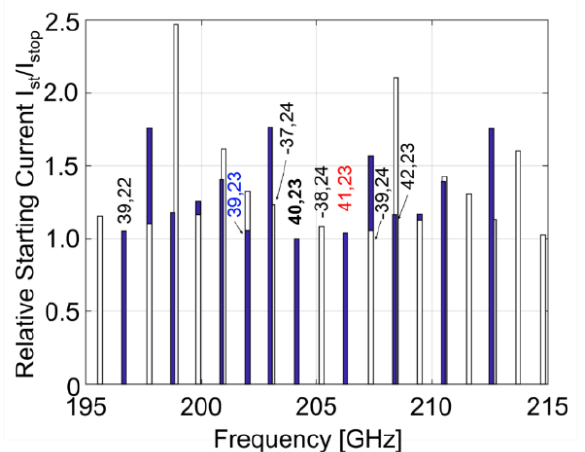
Fig. 2. Adiabatic start-up scenario with existing coaxial cavity at 8.15 T and I beam = 70 A under the consideration of the magnetic field profile of the Oxford Instruments